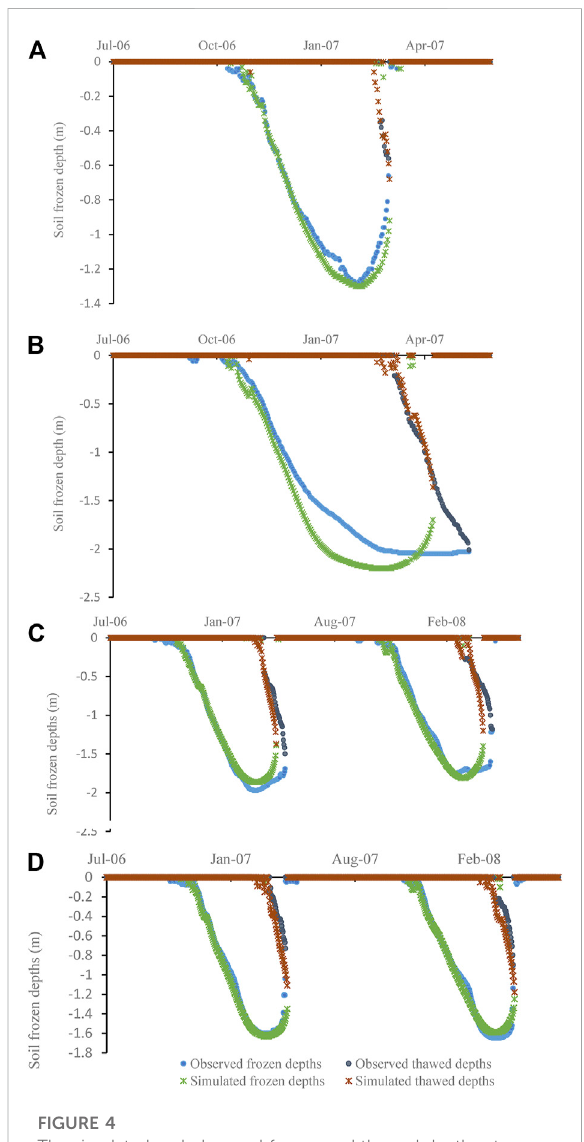
FIGURE 4 The simulated and observed frozen and thawed depths at Zaduo station (A) and Maduo station (B) from 1 July 2007 to 30 June 2008, Dari station (C) and Xinghai station (D) from 1 July 2006 to 30 June